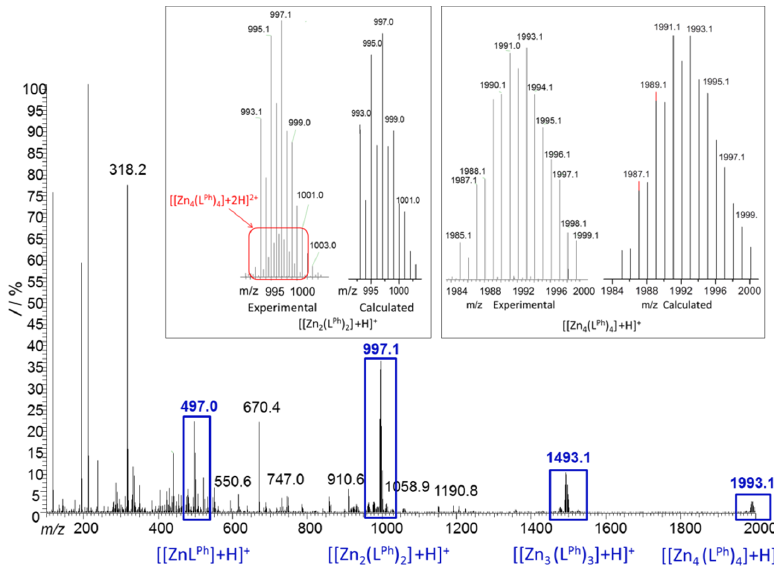
Figure 2. ESI-MS (pos.) of [Zn 4 (L Ph ) 4 ] obtained from an acetone solution. The inserts show the fragments corresponding to the dimer (left), and tetramer (right) with simulations. Marked in red (top left) is the isotopic pattern of the dicationic tetrameric fragment [Zn 4 (L Ph ) 4 ]+2H] 2+ .